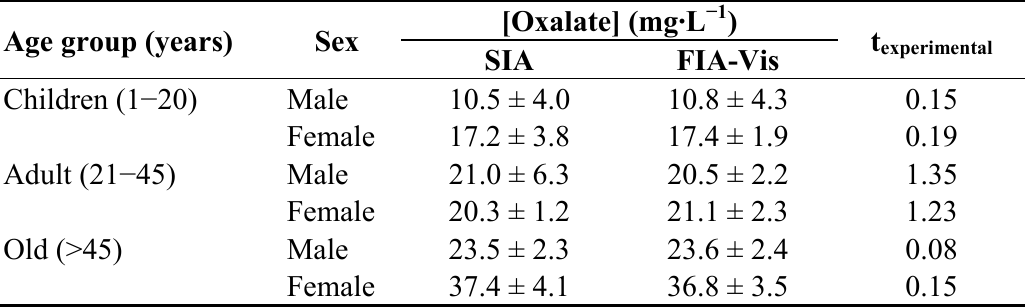
Table 4. Concentration of urinary oxalate (mg·L − 1 , mean ± confidence interval) in healthy individuals determined by SIA and spectrophotometric